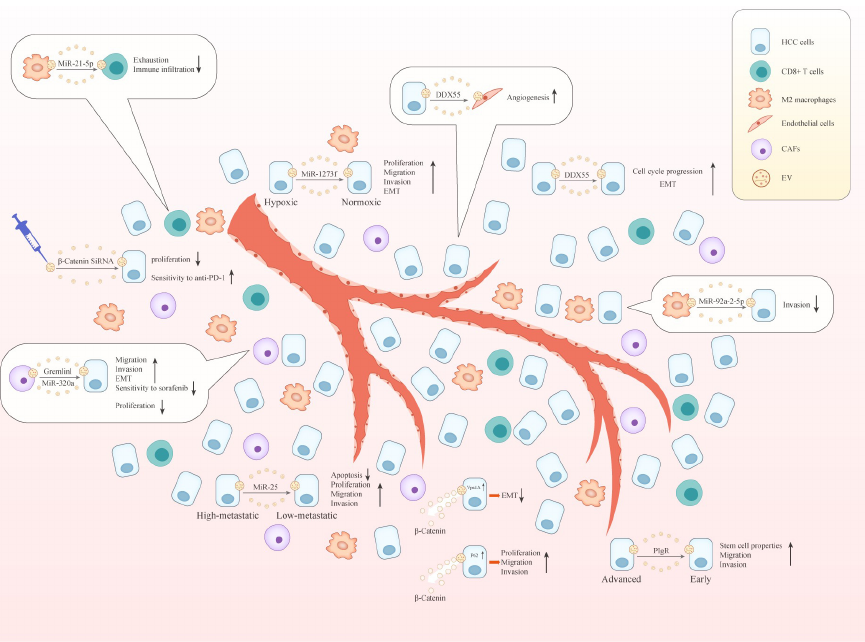
Figure 2. EVs act as cargo delivery carriers and regulate the recipient cell’s biological behavior in HCC TME. ↑ : promotion; ↓ : inhibition.